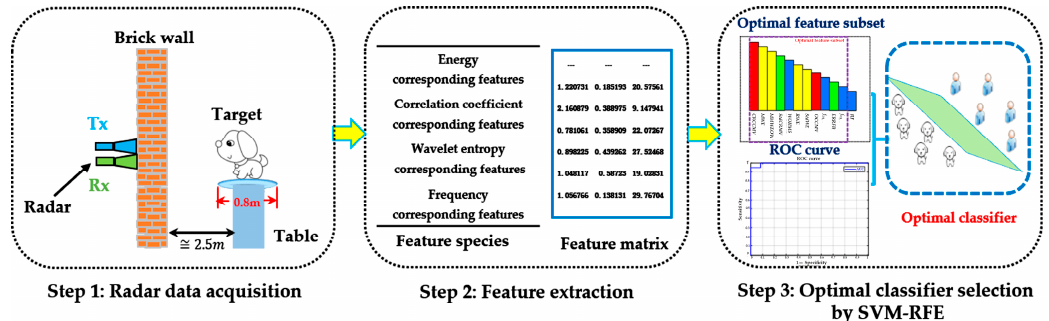
Figure 8. Overall steps of the selection of the optimal classifier. In “ Step 1 : Radar data acquisition”, the raw echo data are collected. In “ Step 2 : Feature extraction”, twelve feature species belonging to four categories are extracted. In “ Step 3 : Optimal classifier selection by SVM ‐ RFE”, an optimal classifier with the highest AUC value is selected.